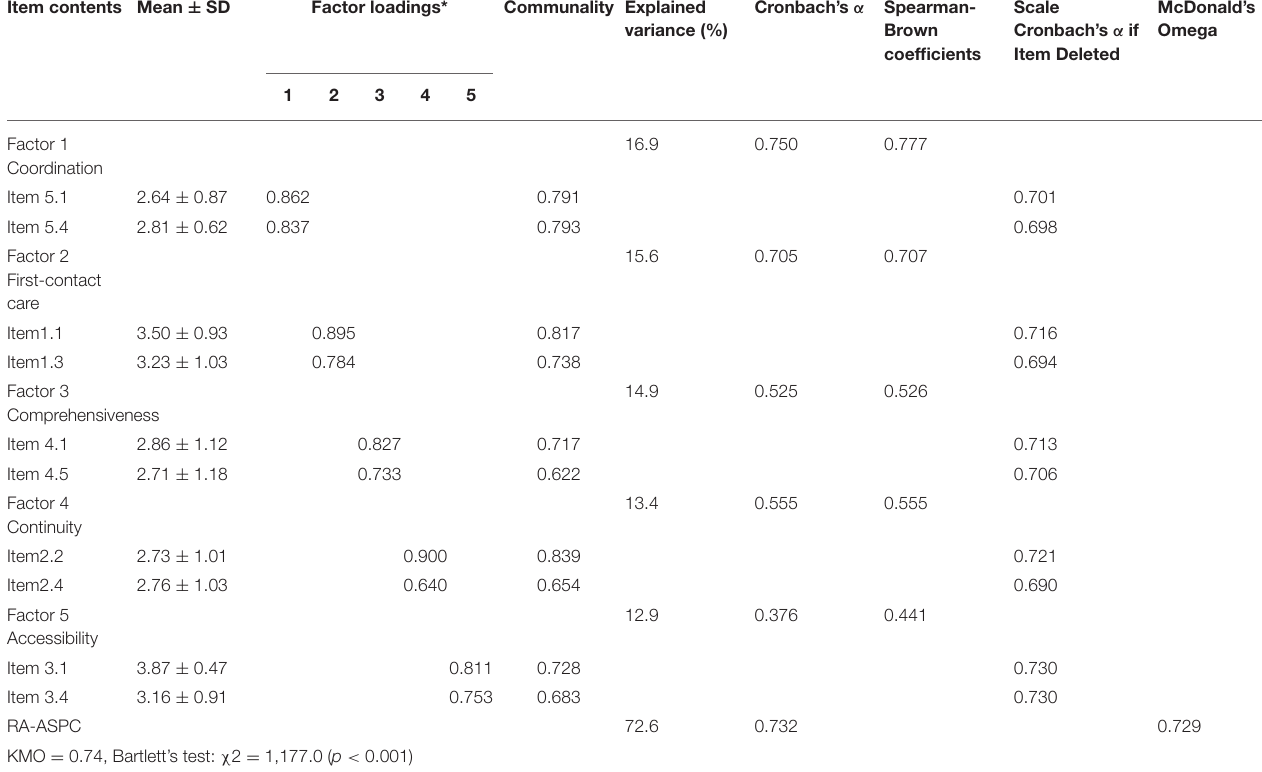
TABLE 3 | Item analysis and factor analysis of the RA-ASPC ( N =